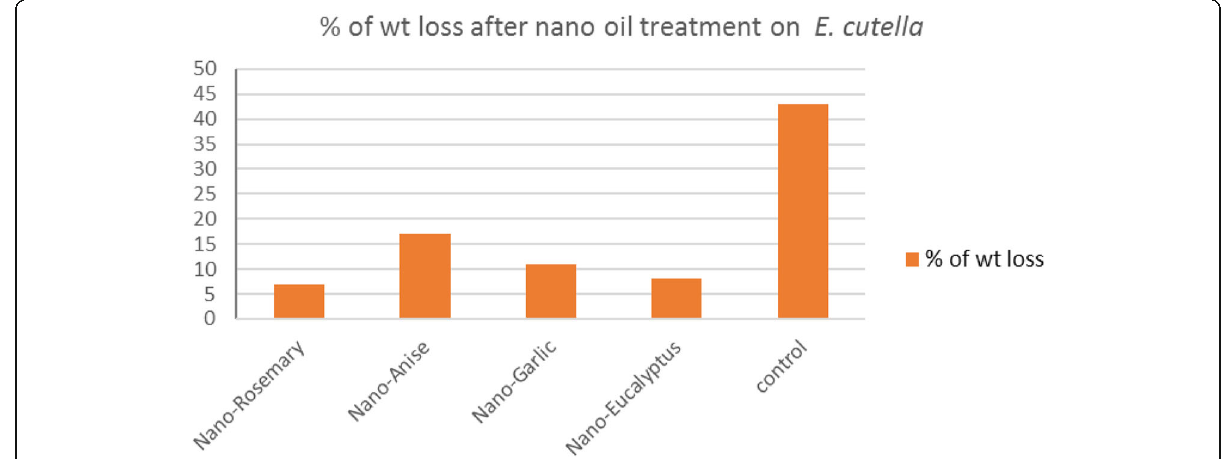
Fig. 2 Percentage of grain weight loss after nano oil treatment on E.